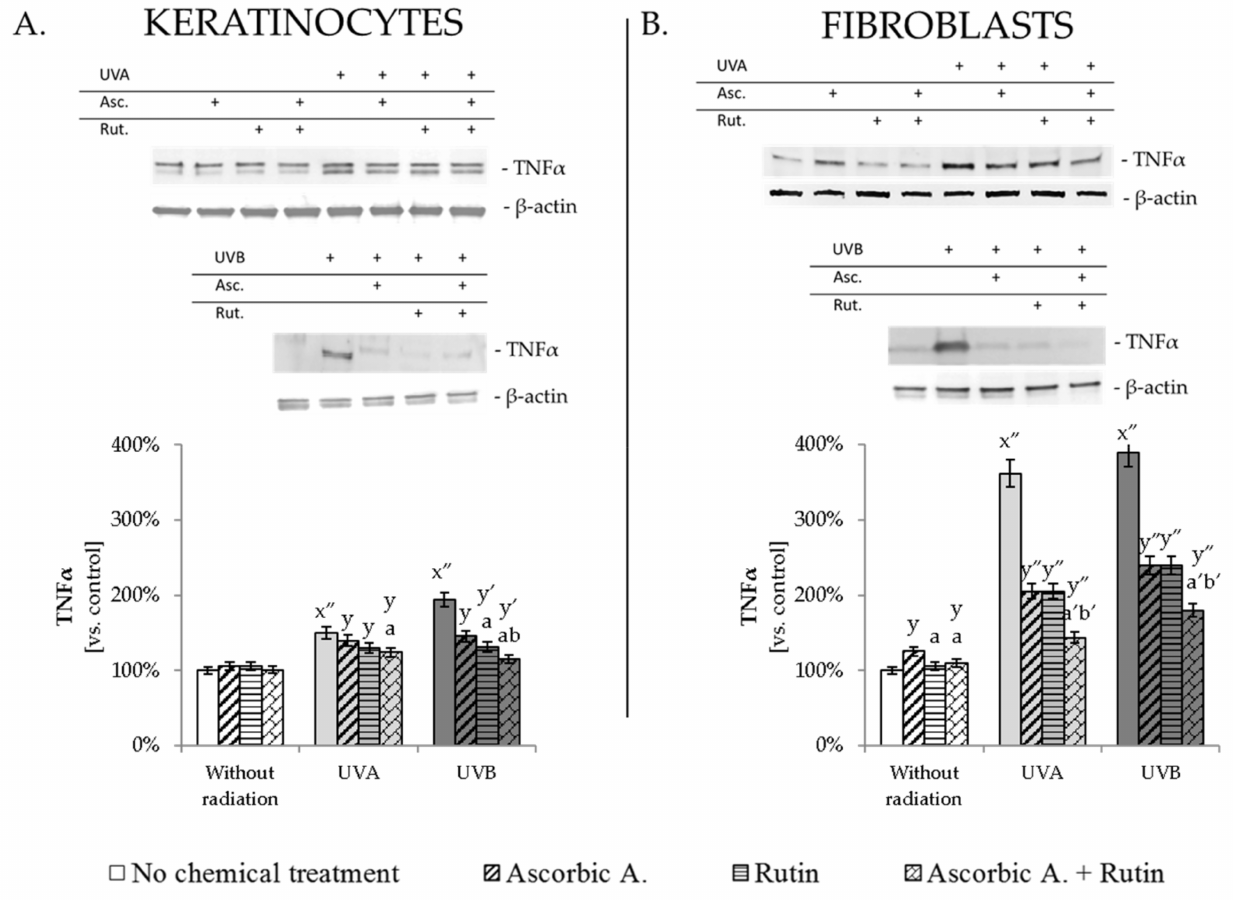
Figure 5. The changes in pro-inflammatory factor TNF α in keratinocytes ( A ) and fibroblasts ( B ) exposed to UVA (30 J/cm 2 and 20 J/cm 2 , respectively) and UVB irradiation (60 mJ/cm 2 and 200 mJ/cm 2 , respectively) and treated with ascorbic acid (Asc., 100 µ M) and rutin (Rut., 25 µ M). Mean values ± SD of three independent experiments are presented. x significant differences vs. non-treated group, respectively (0.005, x” for p < 0.0005); y significant differences vs. group without chemical treatment, respectively (y for p < 0.05; y (cid:48) for p < 0.005, y” for p < 0.0005); a significant differences vs. ascorbic acid-treated group, respectively (a for p < 0.05; a (cid:48) for p < 0.005); b significant differences vs. rutin-treated group, respectively (b for p < 0.05; b (cid:48) for p < 0.005); + indicates the cells treatment in each